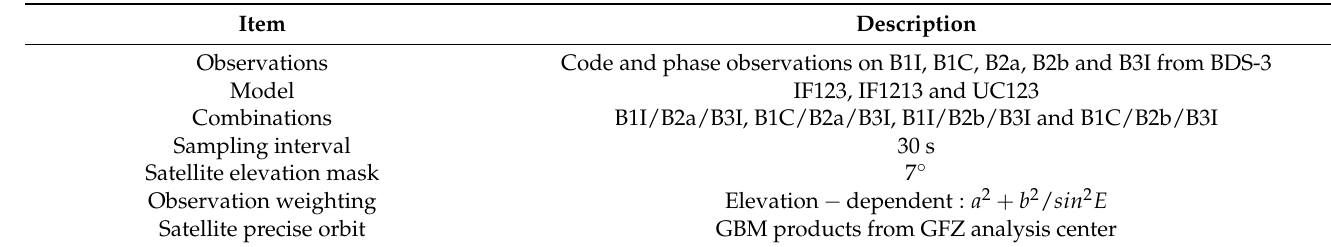
Table 2. BDS-3 triple-frequency data processing